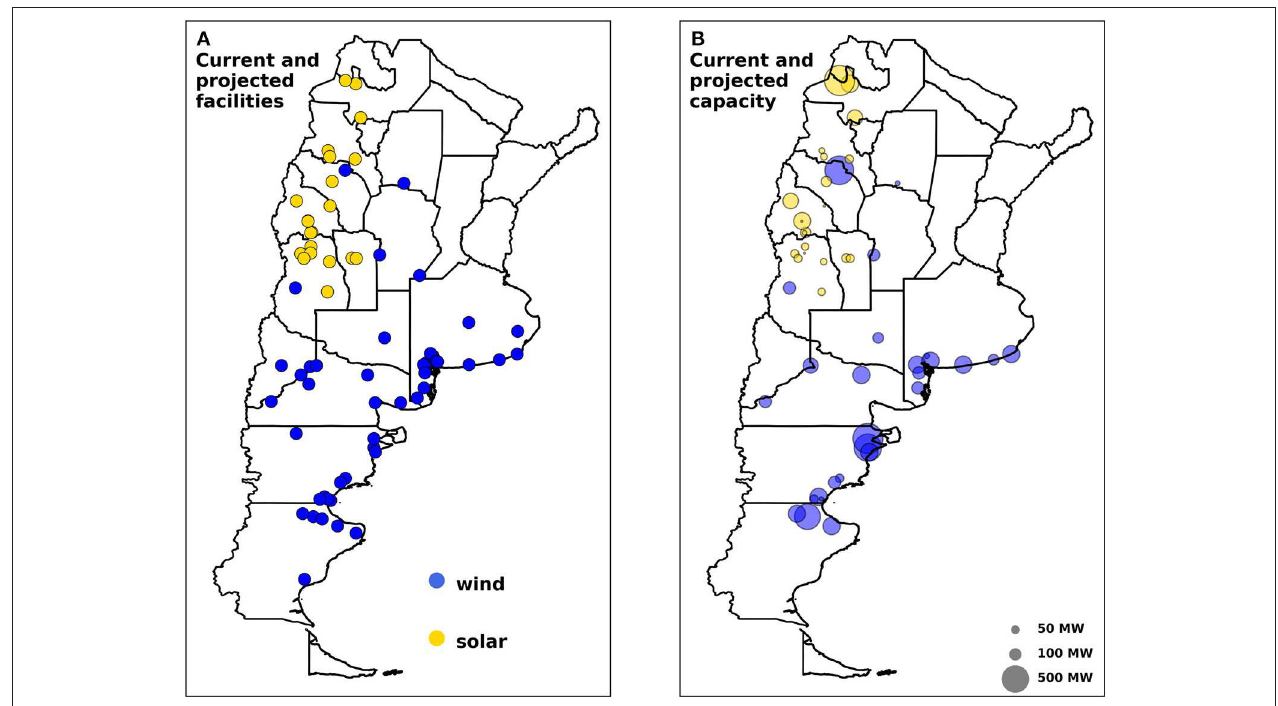
FIGURE 1 | (A) Location of solar (in yellow) and wind (blue) sites. (B) Capacity projected at each site For details at each site see Tables S2 , S3